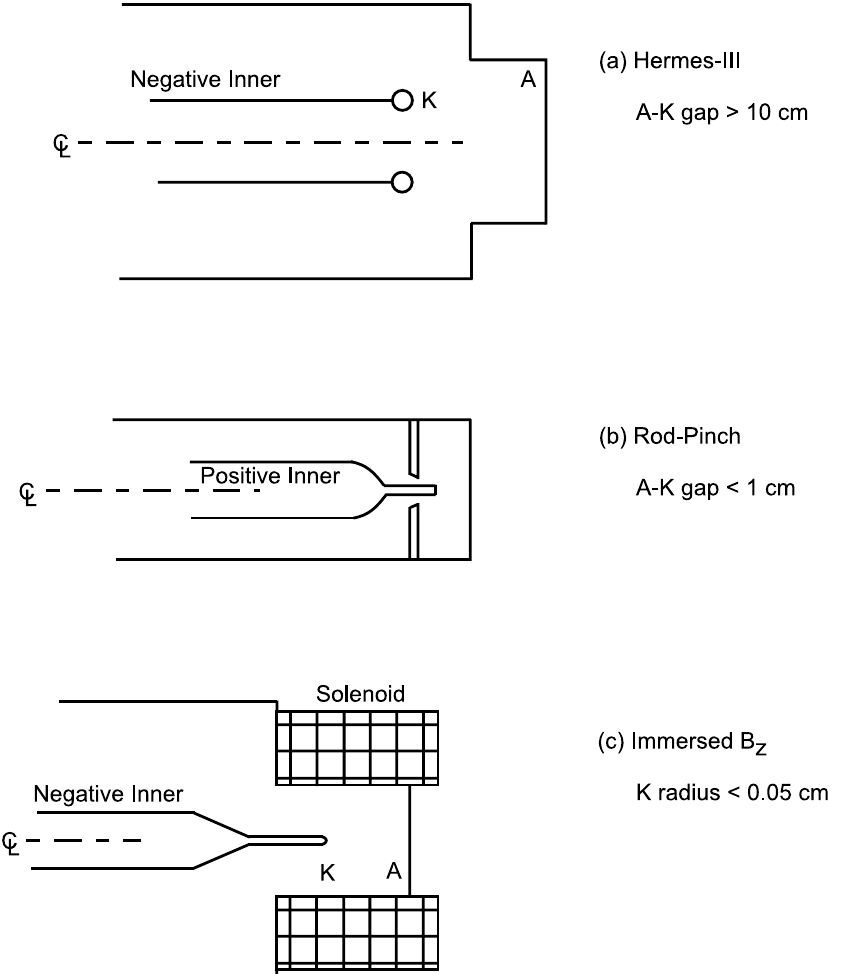
FIG. 30. Diodes with very different sensitivity to prepulse voltages. (a) Hermes-III A - K gap > 10 cm . (b) Rod-pinch A - K gap K radius < 0 : 05 cm < 1 cm . (c) Immersed B z